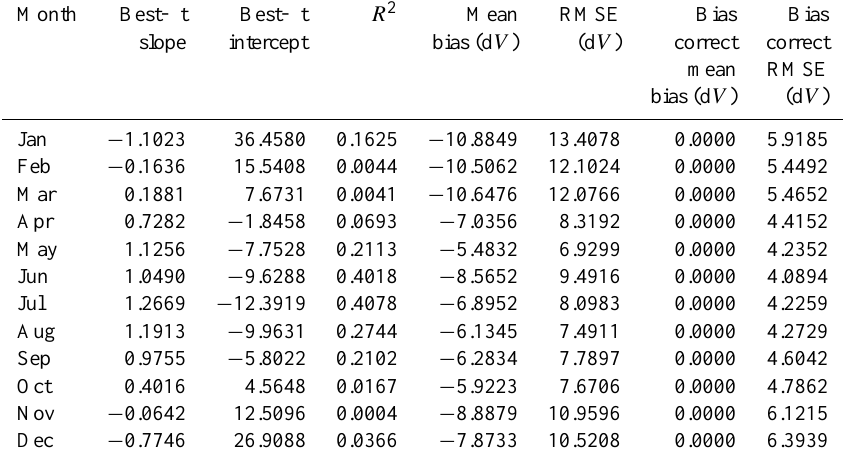
Table 3. Monthly best-fit slope and best-fit intercept for IMPROVE regression (bias correction) and monthly R 2 , mean bias and RMSE for ABI retrieval, and monthly bias-corrected mean bias and bias-corrected RMSE for